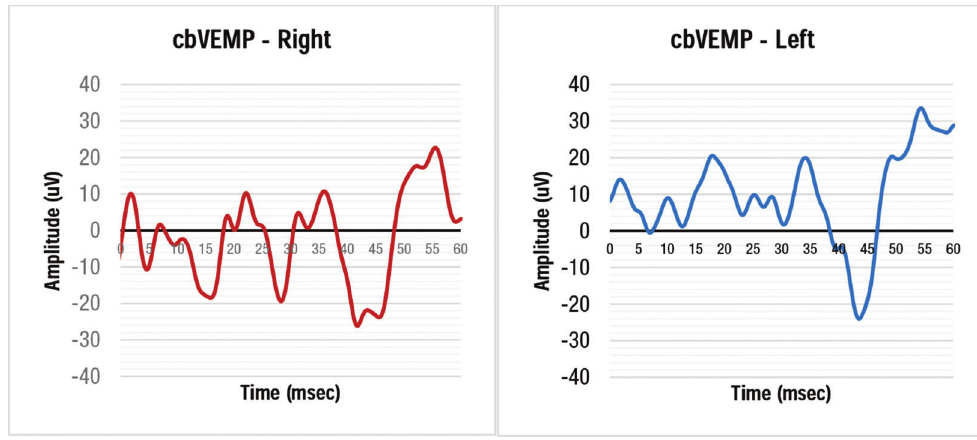
Figure 2 - VEMP grand average of the right and left